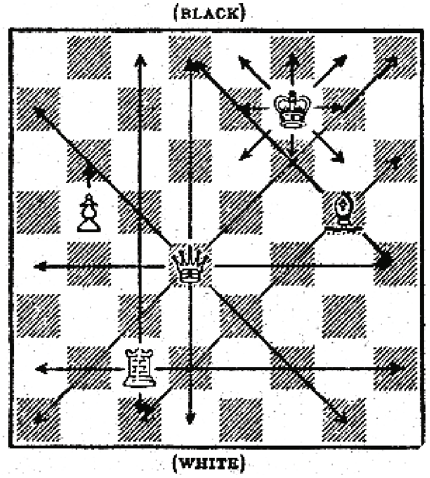
Figure 2: Chess piece movement on a